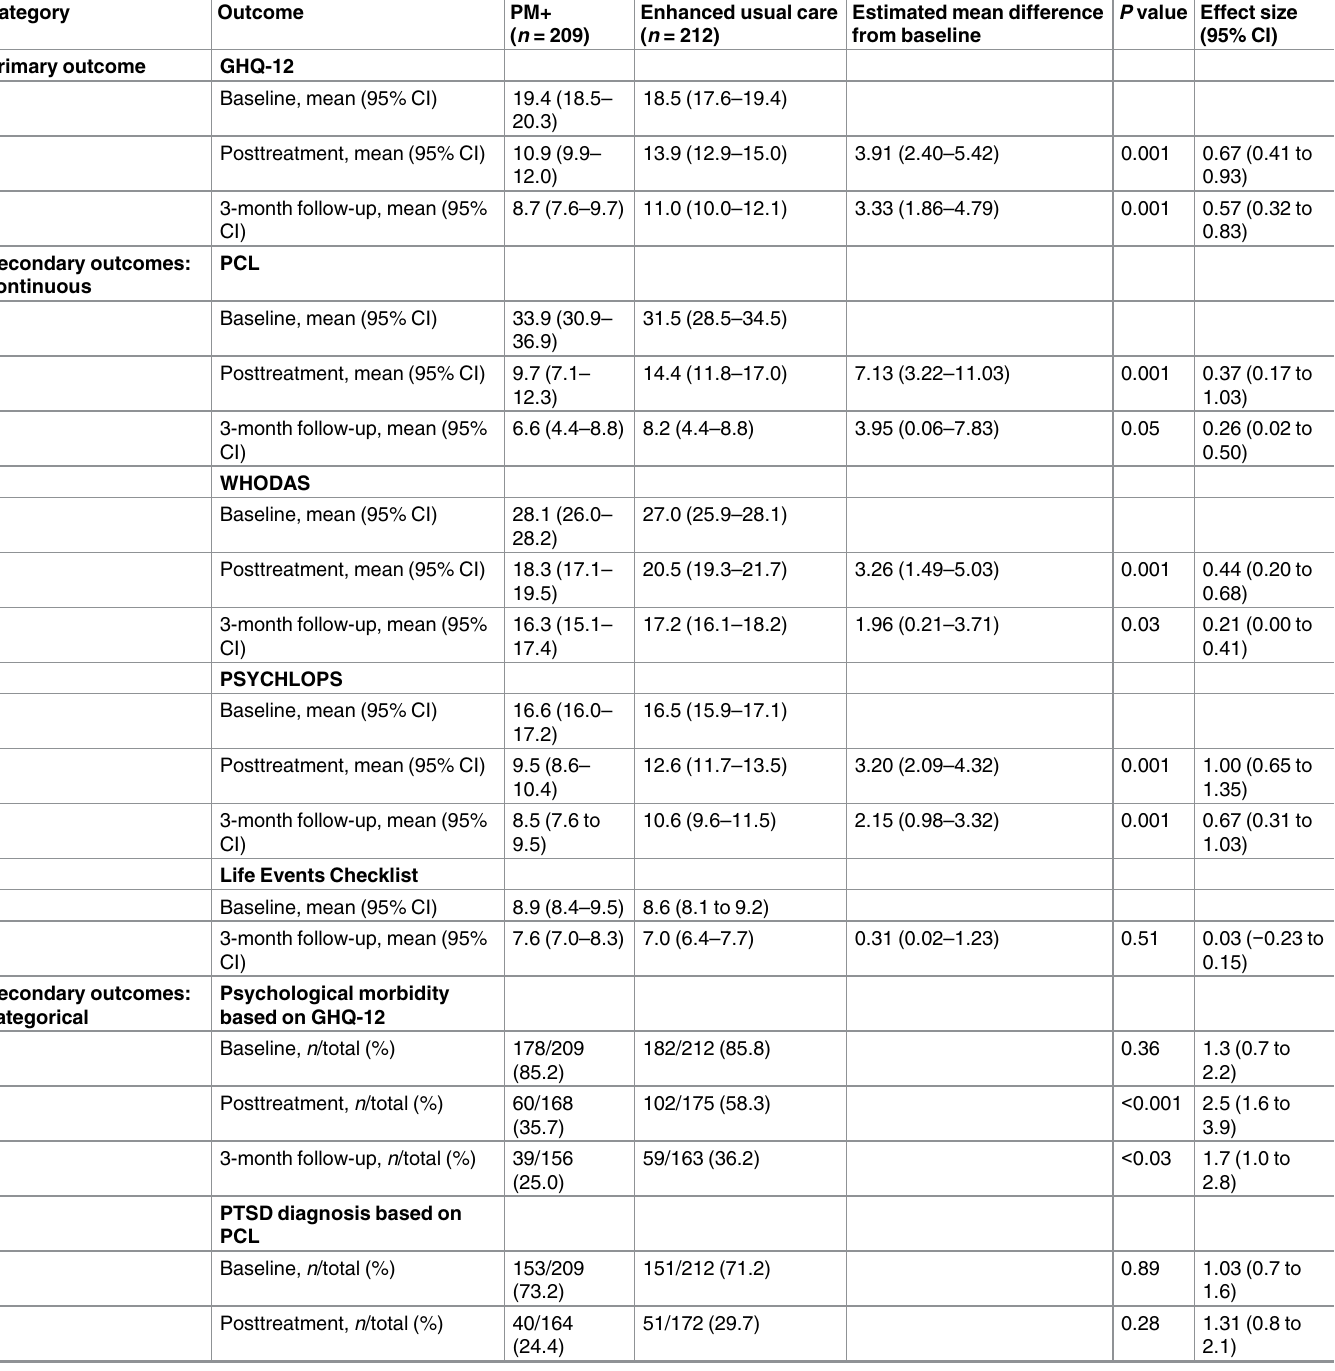
Table 3. Estimated mean scores for primary and secondary outcome measuresat baseline, posttreatment, and 3-month follow-up for women with a history of gender-based violence.